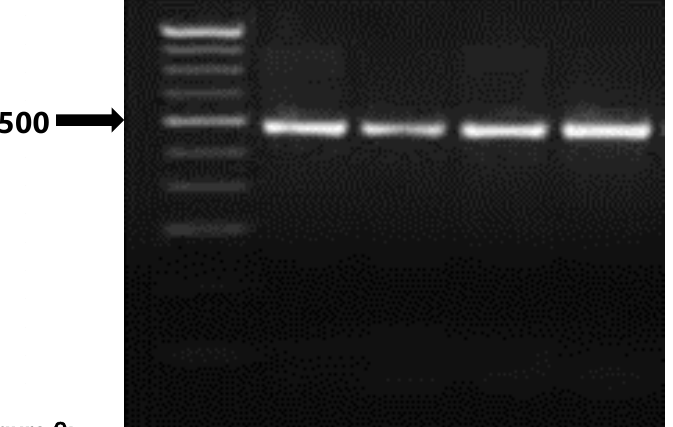
Figure 2: Agarose Gel Electrophoresis of Clinical V. cholerae from this